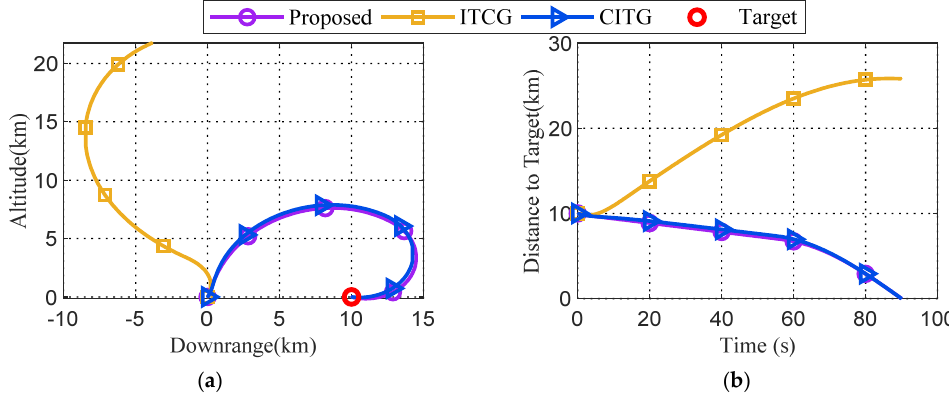
T 90 s. ( a ) Trajectories; ( b ) Distance to tar- T = 90 s. ( a ) Trajectories; ( b ) Distance to tar-